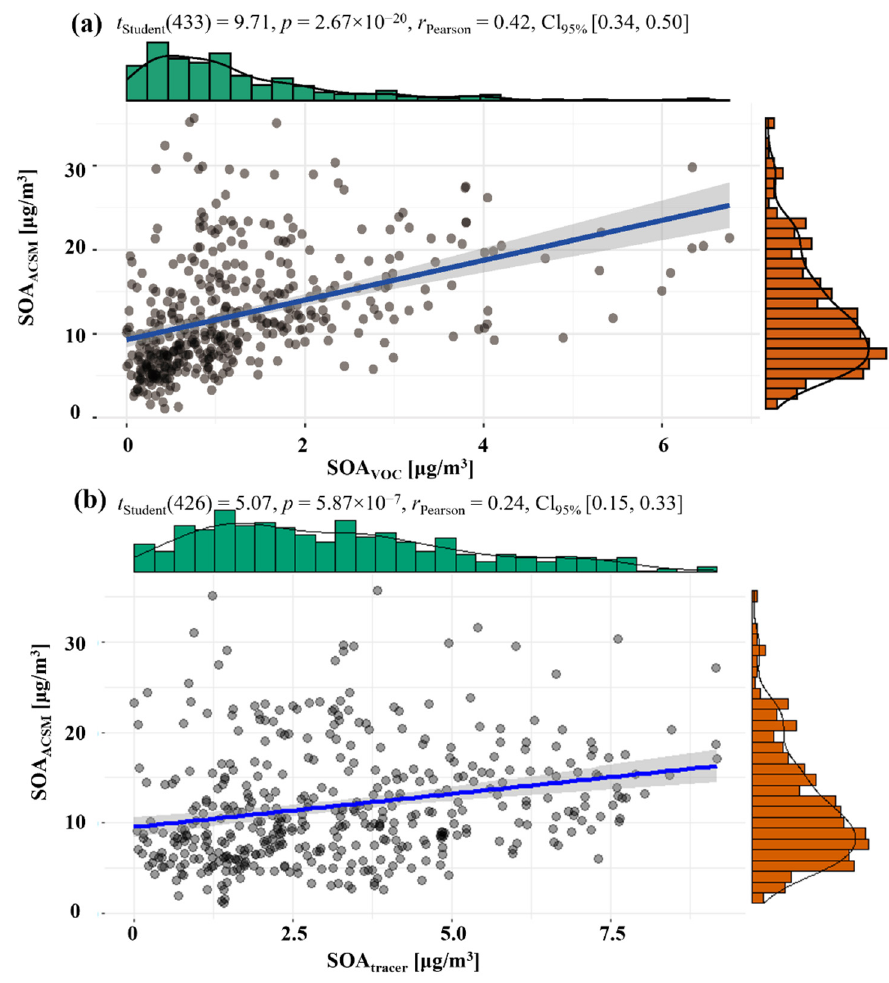
Figure 4. The correlation patterns of ( a ) SOA VOC and SOA ACSM ; ( b ) SOAtracer,SOA ACSM , and the frequency distribution histogram of each method.